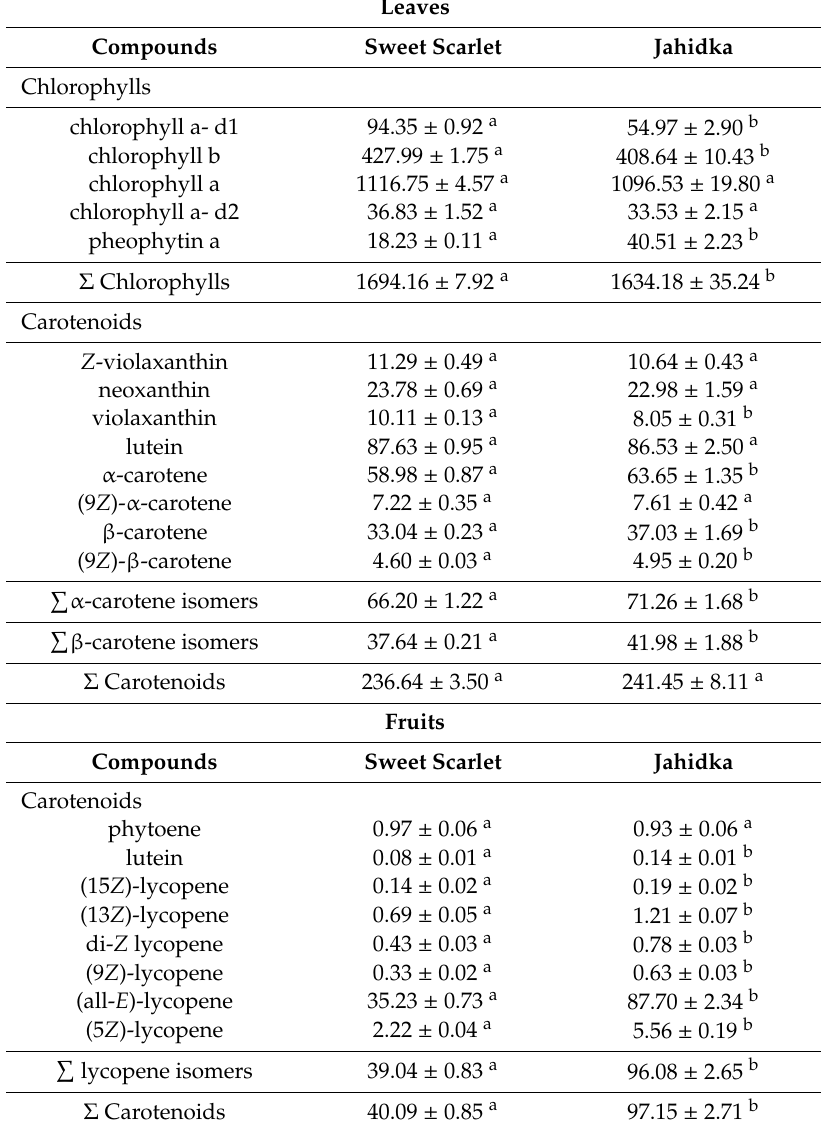
Table 3. Quantification of carotenoids and chlorophylls (mg / 100 g dry matter (d.m.)) in leaves and fruits of Elaeagnus multiflora